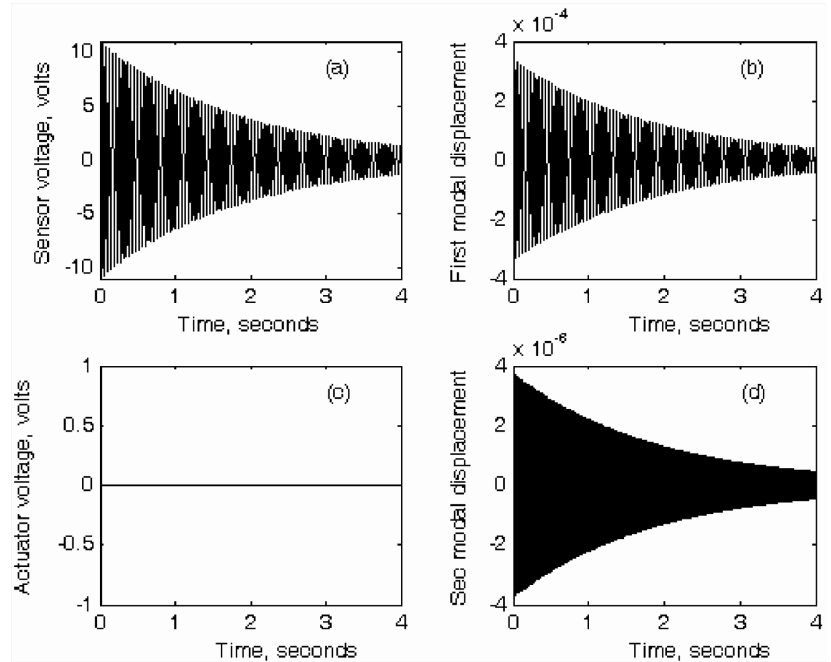
Fig. 5. Uncontrolled response of the (a) sensor voltage, (b) first modal displacement, (c) actuator voltage and (d) second modal displacement.